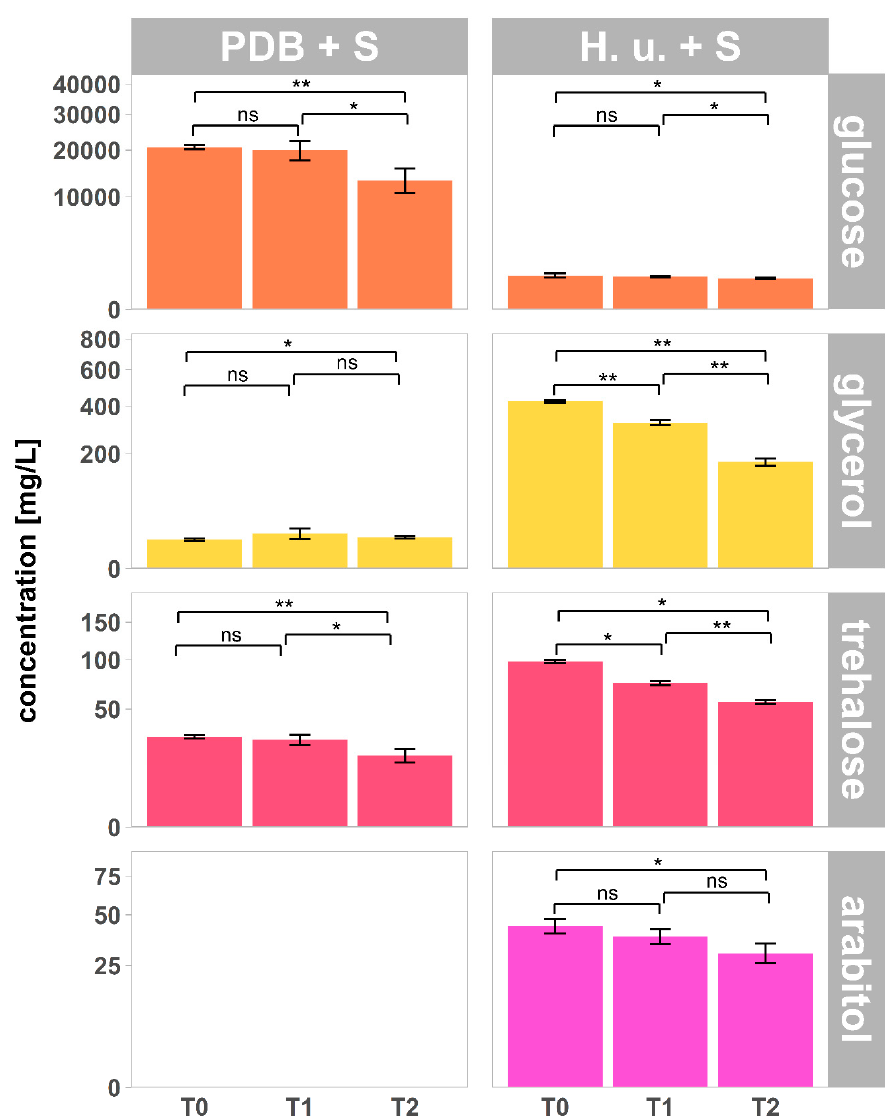
Figure 4. Concentration of glucose and sugar alcohols (mean ± SD; n = 5) in the culture broth PDB + S (T0), in the fermentation broth H. u. + S (T0) and on the surface of leaves treated with PDB + S and H. u. + S collected one day (T1) and one week (T2) after treatment. Arabitol was not detected at any of the timepoints in PDB + S. Asterisks indicate significant di ff erences between timepoints for each treatment ( p < 0.05). Not significant di ff erences are reported, as well (ns). < 0.05 = *; ≤ 0.01 =